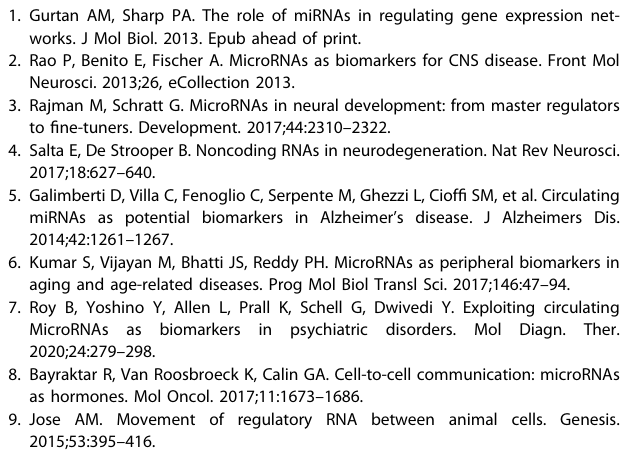
Fig. 5 MicroRNA-409-5p and microRNA-501-3p control synaptic morphology and neuronal activity. A Representative confocal images of dendrites from scramble control and anti-miR treated neurons. B (Left panel) Spine density in anti-miR-409-5p and (Right panel) anti-miR-501- 3p treated neurons in comparison to control. Dots represent dendritic segments acquired randomly from images. y -Axis shows the number of total spines per length of a chosen dendritic segment. (Left panel) number of dendritic segments analyzed, control siRNA = 49, anti-miR-409- 5p = 41. (Right panel) number of dendritic segments analyzed, control siRNA = 49, anti-miR-501-3p = 48. Unpaired t test, two-tailed. Error bars = mean ± SEM. C Representative merged images of scramble control and anti-miRs treated neurons showing IHC staining for Synaptophysin 1, PSD-95, and MAP2. D Number of synapses in anti-miR-409-5p and anti-miR-501-3p treated neurons compared to those from scramble control-treated neurons. Dots represent individual images acquired randomly from the coverslips. Functional synapses were enumerated based on colocalized signals for PSD95 and Synaptophysin 1. y -Axis shows relative percentage of functional synapse in the treatment group(s) compared to controls. (Left panel) Number of images analyzed (control siRNA = 34, anti-miR-409-5p = 34). (Right panel) Number of images analyzed (control siRNA = 34, anti-miR-501-3p = 33). Unpaired t test, two-tailed. Error bar indicates mean ± SEM. E Primary hippocampal neurons were cultured on a Axion MEA plate and treated with lipid nanoparticles (LNPs) containing anti-miR cocktail of microRNA-409-5p and microRNA-501-3p at DIV 7. Neurons treated with scramble control were treated as controls. At DIV10, spontaneous neuronal activity was recorded at every 3 h for 10 min. The complete recording session lasted for 24 h. Left panel shows representative raw data traces from one electrode from a MEA plate from treatment and control groups (top) and representative low and high magni fi cation images from a neuronal culture grown in one well of the MEA plate. The right panel shows from left to right thrree datasets; the Mean fi